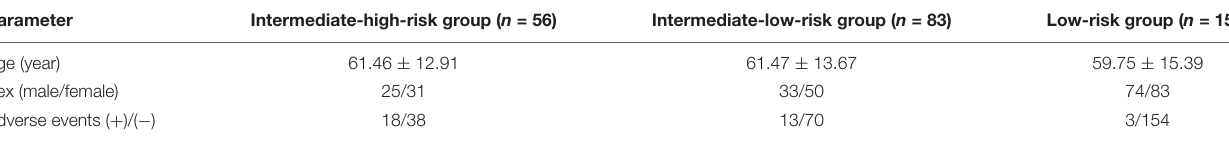
TABLE 3 | Risk stratification groups for all enrolled